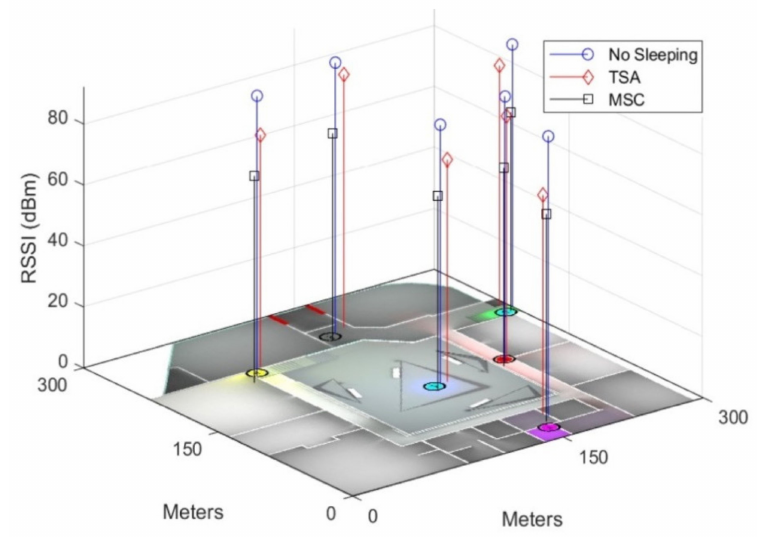
Figure 12. Analysis of the Zigbee sensors under no sleeping, TSA, and MSC for MPH (proactive